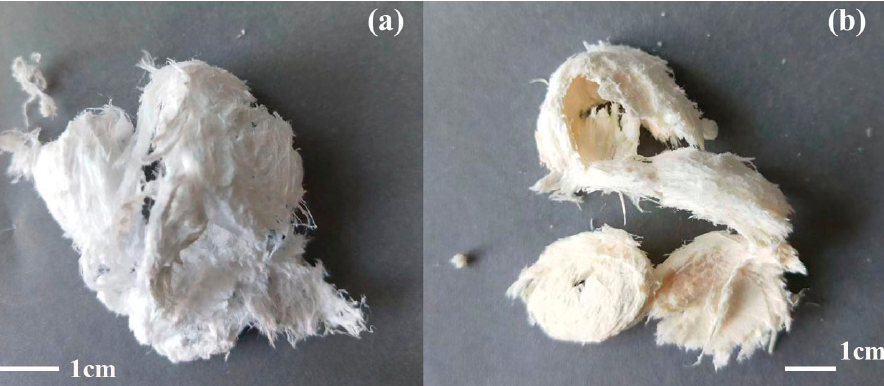
Figure 1. ( a ) Polylactic acid (PLA) and ( b ) covalent organic frameworks (COFs)-modified PLA (COF-PLA).